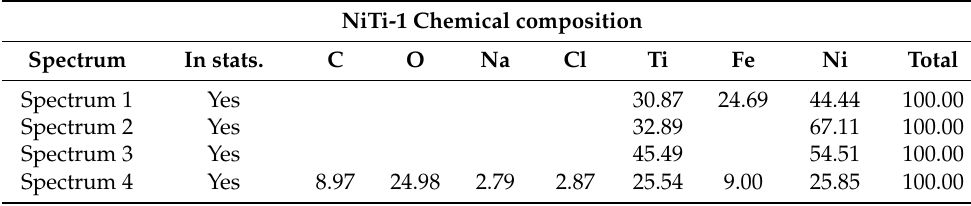
Table 2. Chemical composition of the NiTi-1 corrosion layers identified by EDS analysis. NiTi-1 Chemical